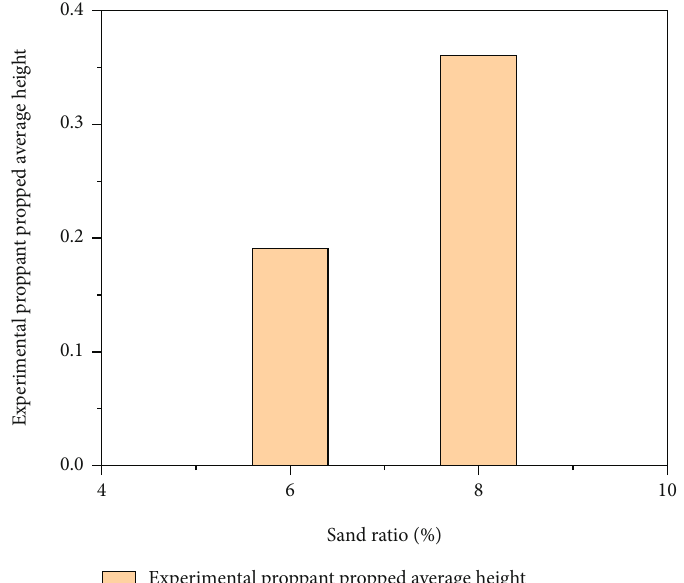
Figure 6: Comparison diagram of 20/40 mesh quartz sand placement results with di ff erent sand ratios.